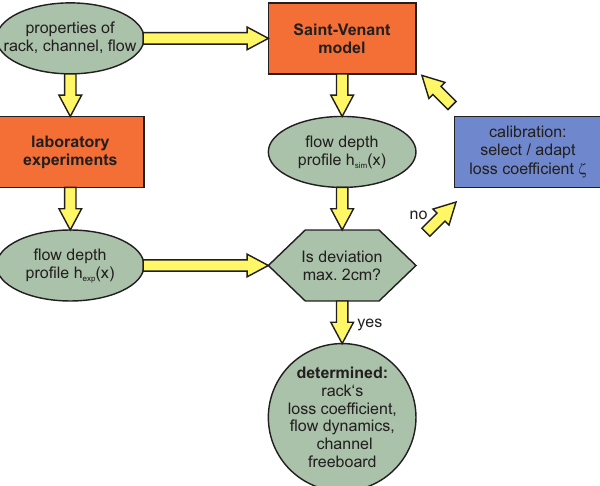
Figure 7. Hybrid workflow in this study to determine the loss coefficient of the rack, the entire flow dynamics, and the channel freeboard. The flowchart starts in the top left corner by selecting the properties of the rack, the channel, and the